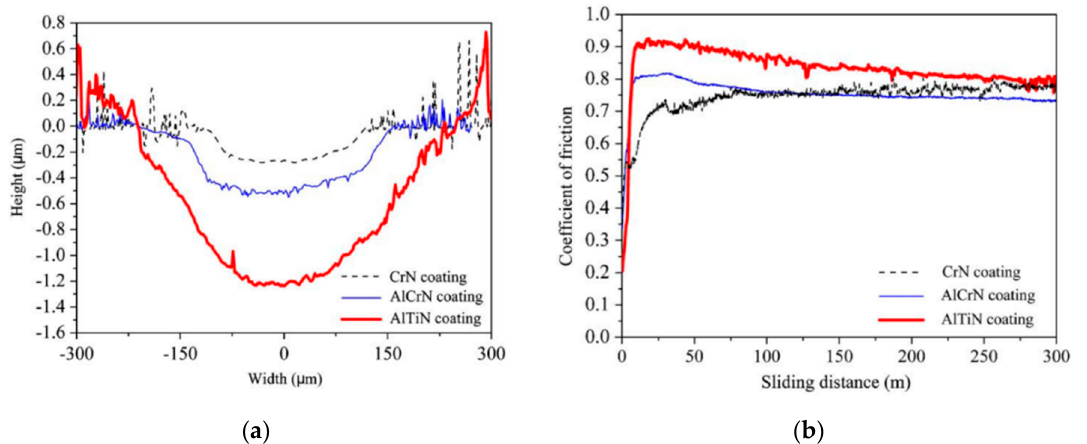
Figure 17. Wear track profiles ( a ) and coefficients of friction ( b ) of the 2 μ m thick CrN, 1 μ m thick AlCrN and 2 μ m thick AlTiN coatings deposited on cemented carbide (10 wt.% Co and 90 wt.% WC) using the multi-arc ion plating technique, after the entire tests performed at the normal load of 5 N; the sliding velocities of 10m/min; the wear track nominal diameter of 10 mm; the total sliding distance of 300 m, using a Si 3 N 4 ball with diameter of 4mm, surface roughness Ra of 0.02 µ m and hardness of HV 50 1600 as the counterpart, reprinted from Tribology International , Reference [133], with permission from Elsevier.